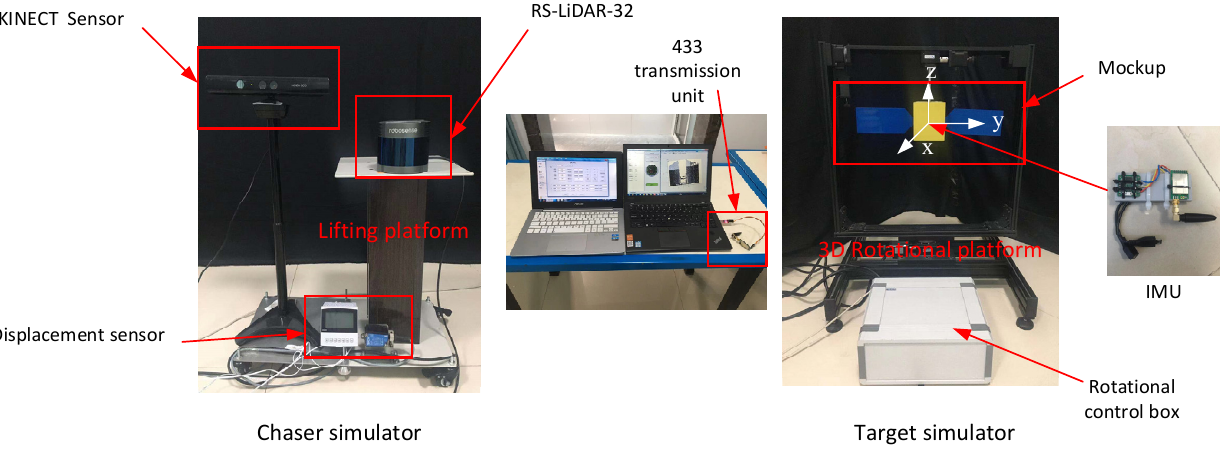
Figure 9. Experimental device for simulating the relative motion between the spacecraft and target spacecraft. Table 4. Kinect 1.0 specifications.